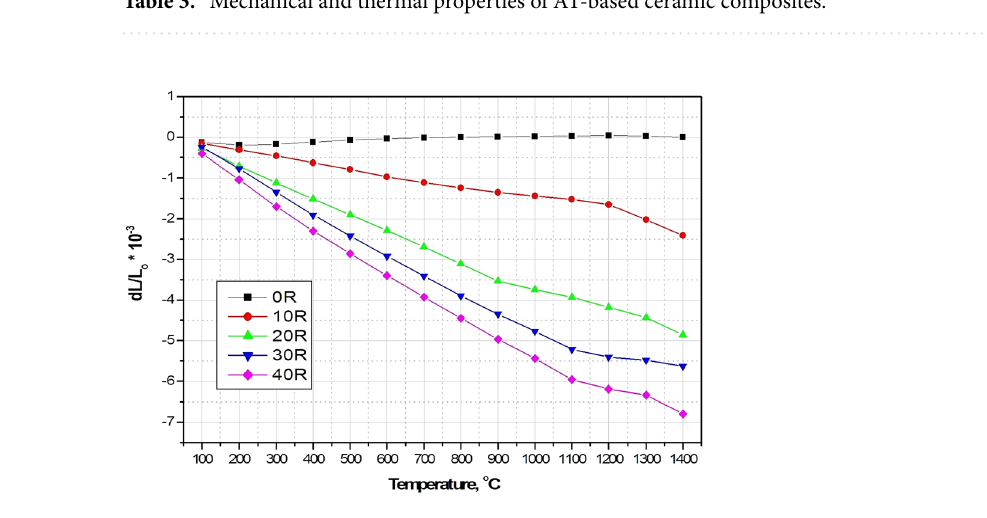
Table 3. Mechanical and thermal properties of AT-based ceramic composites.